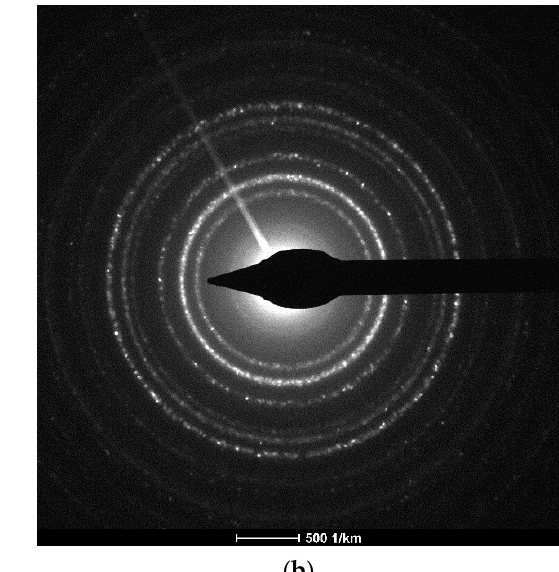
Figure 3. The FT-IR spectrum of Fe 3 O 4 -PABA . BET analysis (Figures S3 and S4 in the Supplementary Materials) provided the spe- cific surface area of the Fe 3 O 4 -PABA nanoparticles. The specific surface of the obtained material was 124 m 2 g − 1 , with pore size and volume dBJH = 12.019 nm and Vp = 0.295 cm 3 g − 1 . To obtain an efficient surface functionalization of the final composite nanoparti- cles, a further silica shell was obtained ( MW-NPS ). The silanolic rich surface provides an easy and efficient subsequent functionalization [18]. As determined by magnetic meas- urements, the final material retains its magnetic properties, which allows easy and fast